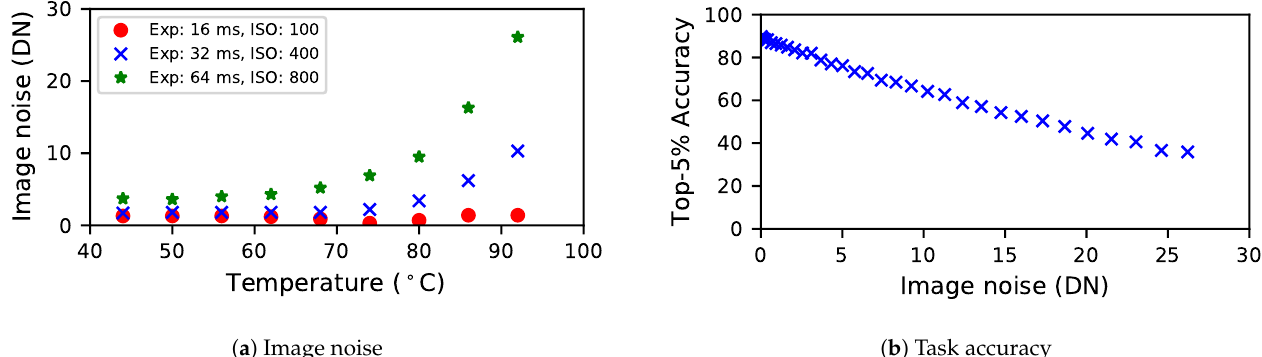
Figure 4. Variance of noise, expressed in pixel intensities, and task accuracy showing sensitivity to temperature, exposure, and